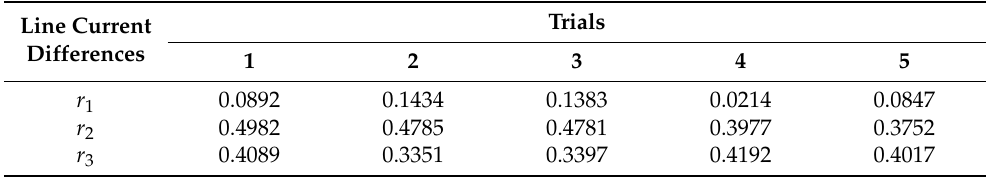
Table 4. Arithmetic differences of the line current RMS values from a motor with 5% of the coils in its phase I c winding short